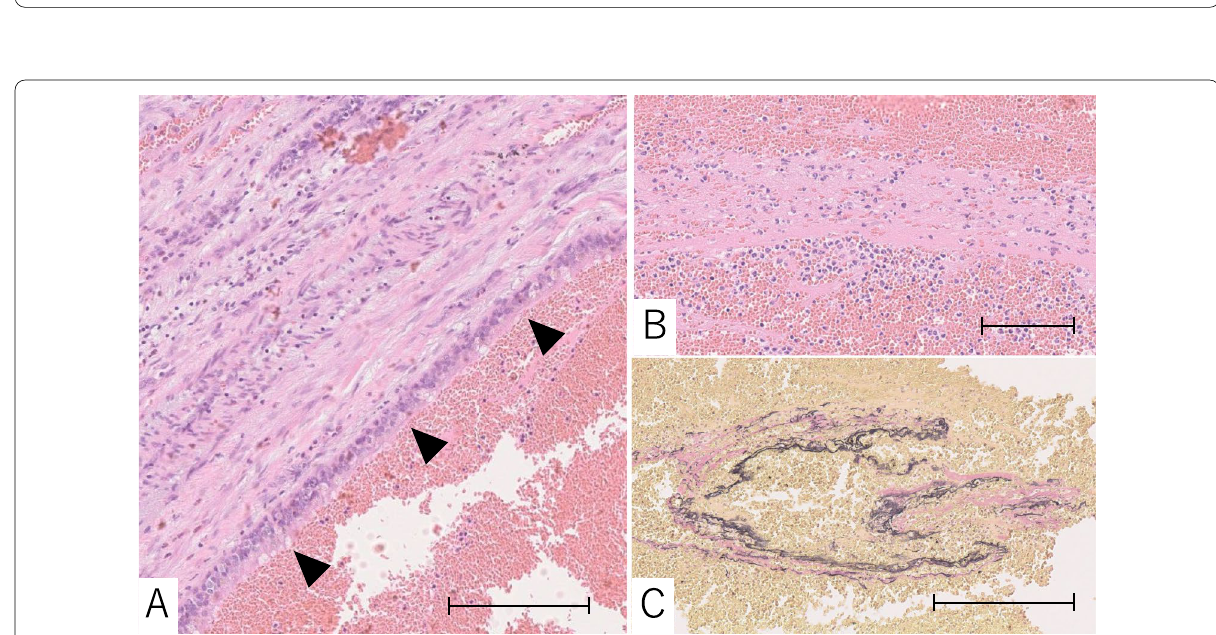
Fig. 4 A Histopathological findings showing that the primary bleeding site was within the focally dilated bronchiole (scale bar: 200 μm). The arrowheads indicate ciliated bronchial epithelial cells. B The dilated bronchiole wall is accompanied by neutrophil infiltration, suggesting